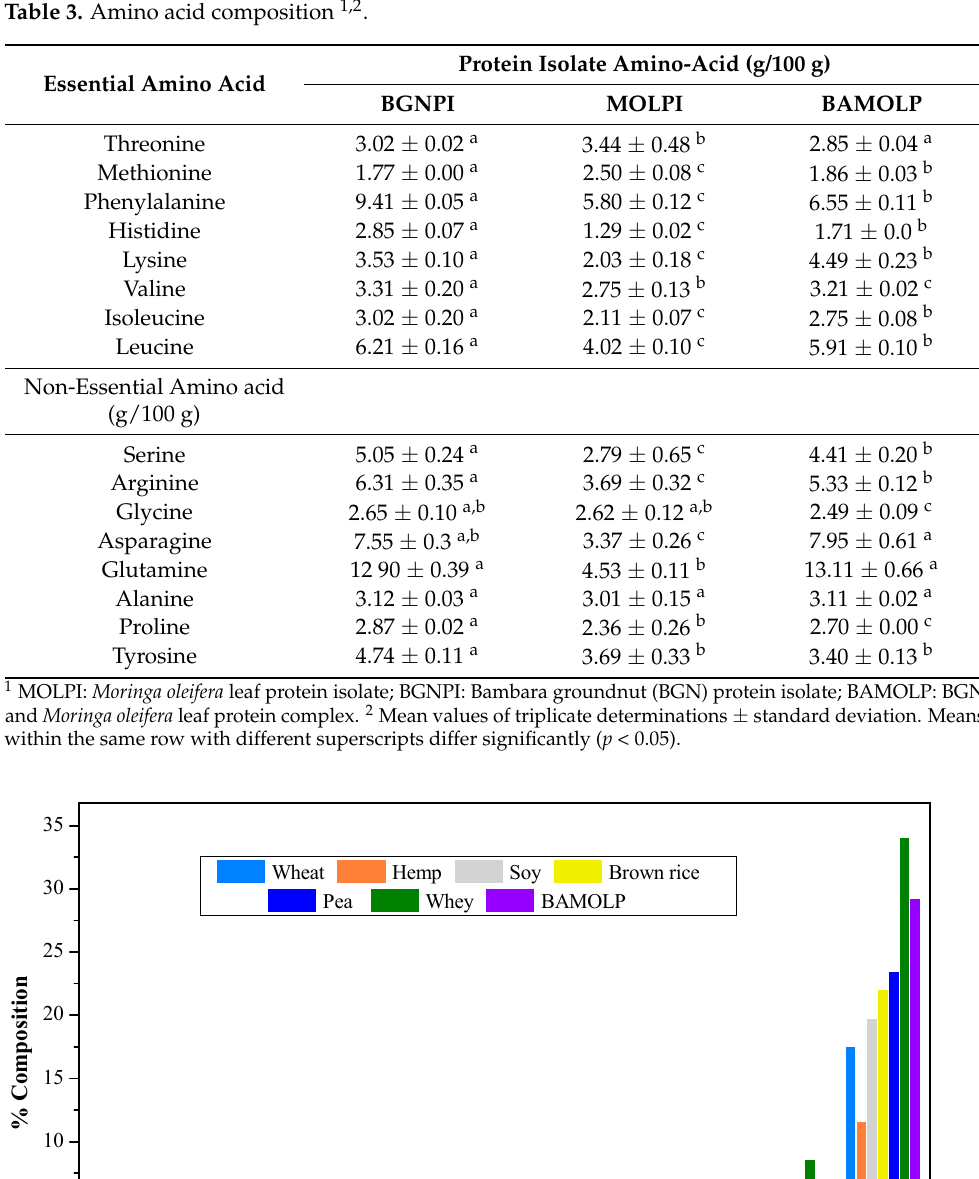
Table 3. Amino acid composition 1,2 .